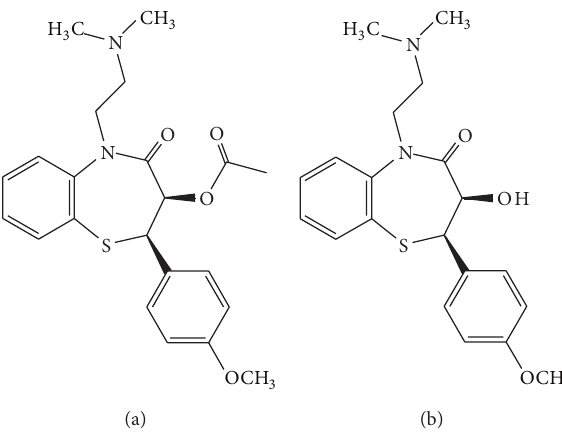
Figure 1: Molecular structures of diltiazem (a) and desacetyl diltiazem